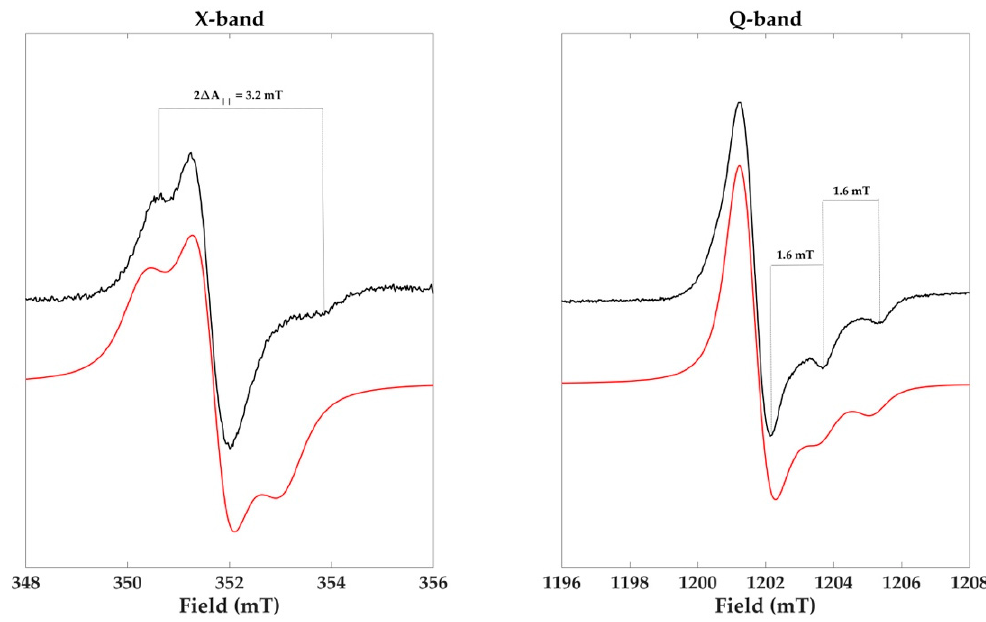
Figure 5. X- (9.9 GHz) and Q-band (33.7 GHz) spectra of the cysteinyldopa melanin paired with their simulated spectra (red line).